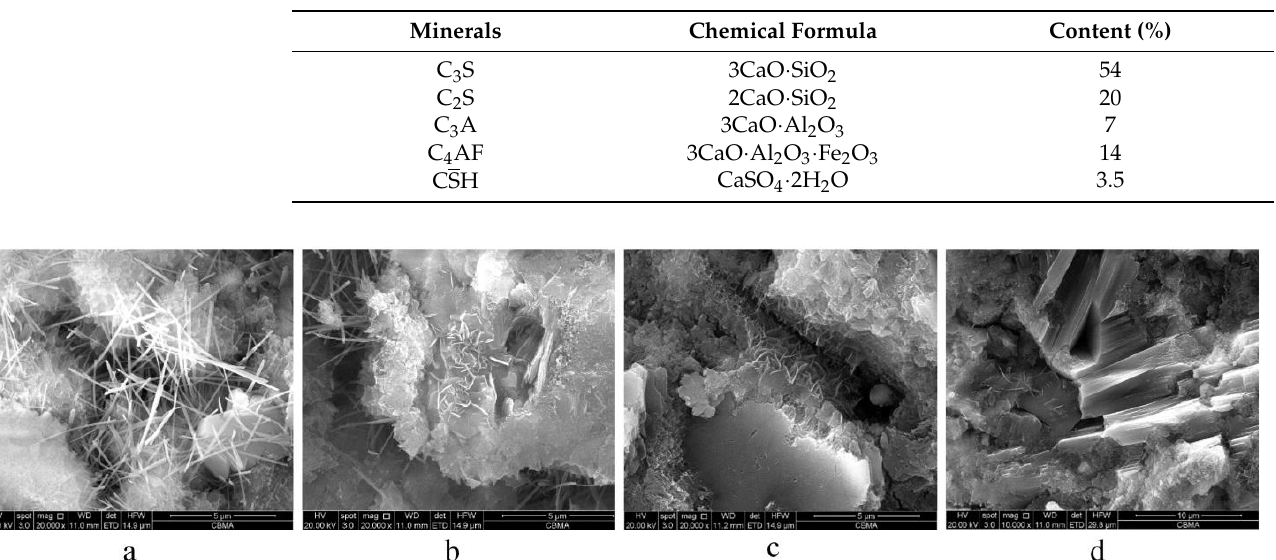
Table 1. Mineral composition of ordinary Portland cement clinker in China [36].